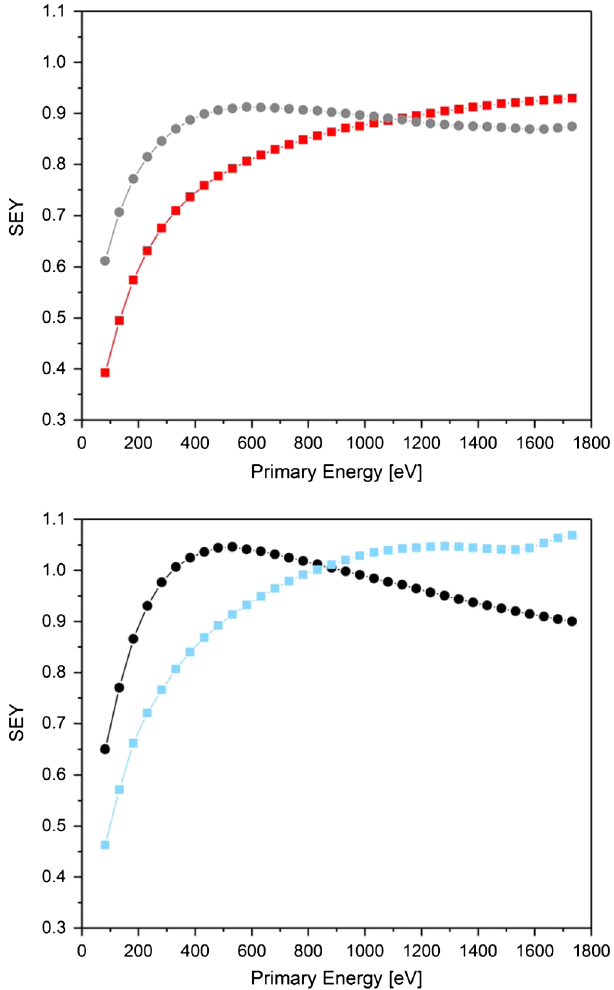
FIG. 10. SEY curves for: (top) LH samples produced at the University of Dundee before (red squares) and after (grey circles) the CERN standard cleaning procedure; (bottom) LH 120 mm = s samples from ASTeC before (light blue squares) and after (black circles) the same cleaning